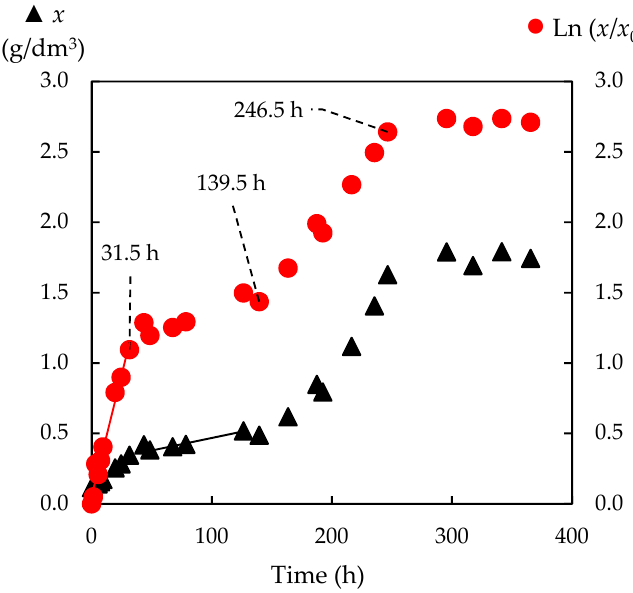
Figure 7. P. tannophilus growth curve under microaerobic conditions at 30 °C and pH 4.5.